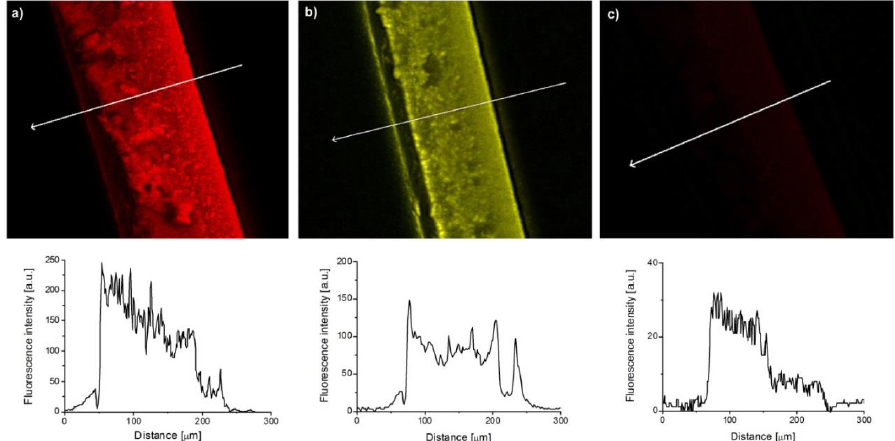
Figure 7. Upper row: confocal images of the membranes after filtration in clear filtration areas for ( a ) rhodamine B (RB) and ( b ) phenol red (PR), and for ( c ) RB in an area in contact with the ceramic support. Bottom row: profiles of fluorescence intensity along the respective line; (arrows in the upper panels indicate the flow of filtration and the direction of the filtration distance coordinate).